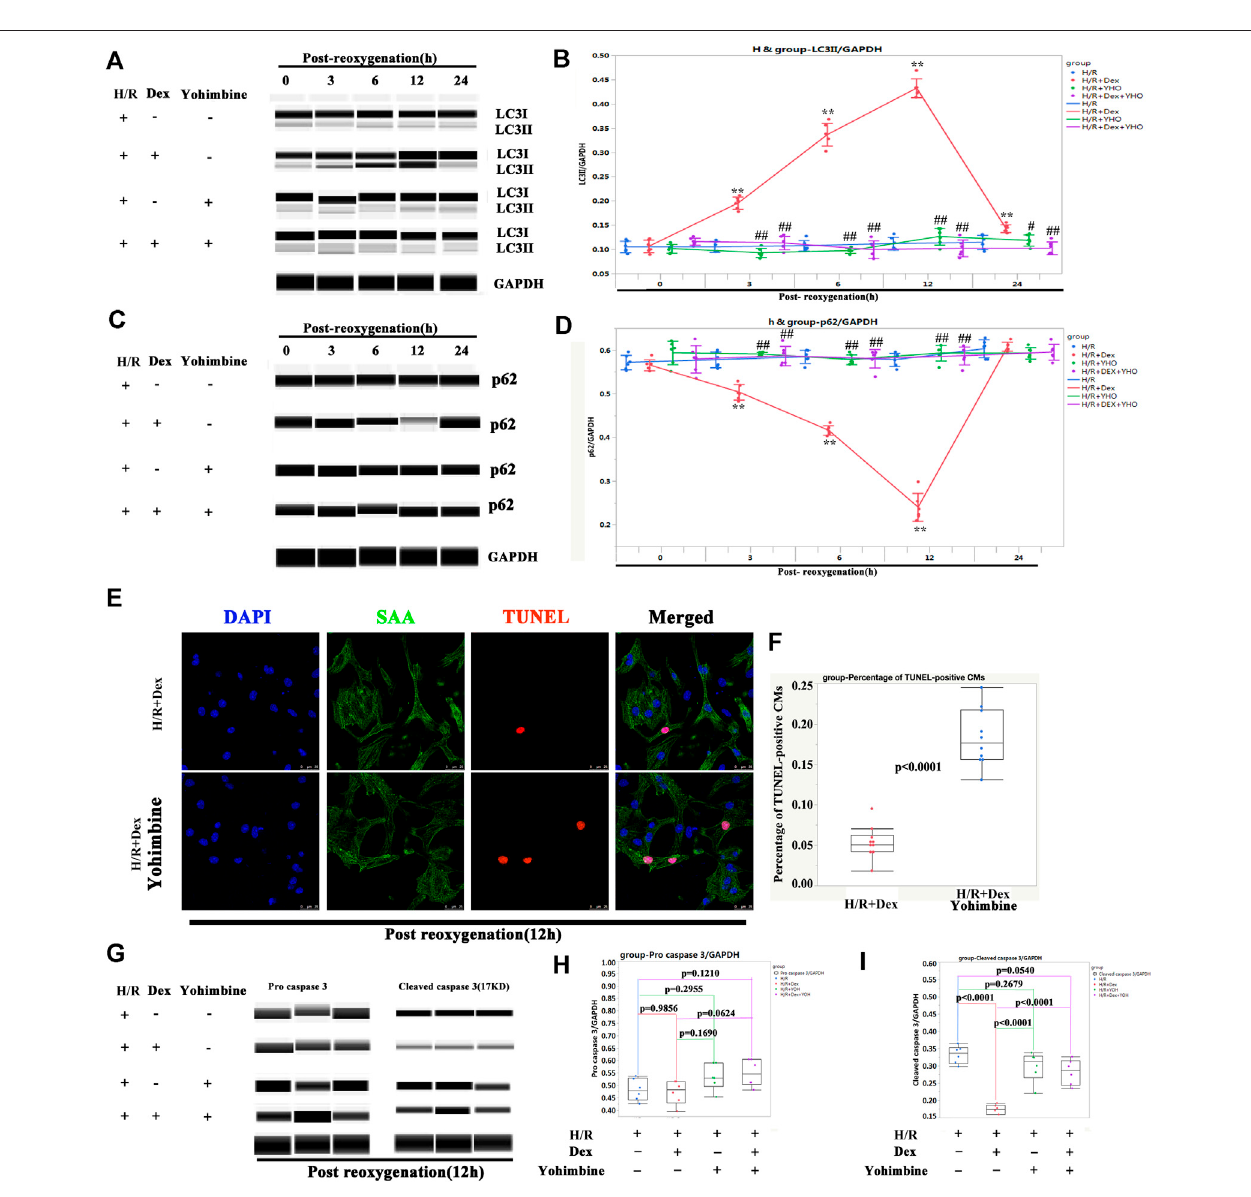
FIGURE 7 | The protection of Dex was α 2-adrenergic receptor dependent. (A) Representative LC3II Wes blot of iPSC-CMs pretreated with Dex and yohimbine ( α 2-adrenergic receptor antagonist). (B) Quanti fi cation of the LC3II relative expression. N (cid:2) 3 independent experiments. (C) Representative p62 Wes blot of iPSC-CMs pretreated with Dex and yohimbine. (D) Quanti fi cation of the p62 relative expression. N (cid:2) 3 independent experiments. (E) Representative TUNEL-positive CMs after treatment with Dex and yohimbine during the H/R process. (F) Quanti fi cation of the TUNEL-positive CMs. N (cid:2) 10 fi elds. (G) Representative pro-cleaved caspase 3 Wes blot of iPSC-CMs pretreated with Dex and yohimbine. (H) Quanti fi cation of the pro-caspase 3 relative expression. N (cid:2) 6 replicates. (I) Quanti fi cation of the cleaved caspase 3 relative expression. N (cid:2) 6 replicates. ** p < 0.01. vs. H/R; ## p < 0.01, vs. H/R +